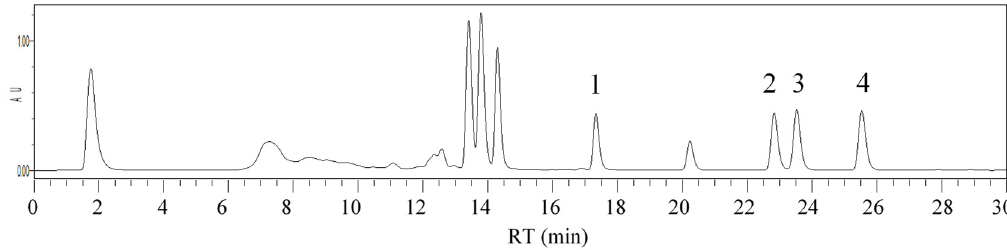
Figure 6. QuEChERS-dSPE / UHPLC-PDA chromatogram at 224 nm for a potato matrix spiked with Figure 6. QuEChERS ‐ dSPE/UHPLC ‐ PDA chromatogram at 224 nm for a potato matrix spiked with insecticide residues at 20 µ g / kg. Peak identification: 1. Chlorpyrifos; 2. λ -Cyhalothrin; 3. insecticide residues at 20 μ g/kg. Peak identification: 1. Chlorpyrifos; 2. λ‐ Cyhalothrin; 3. Deltamethrin; 4. Acrinathrin.